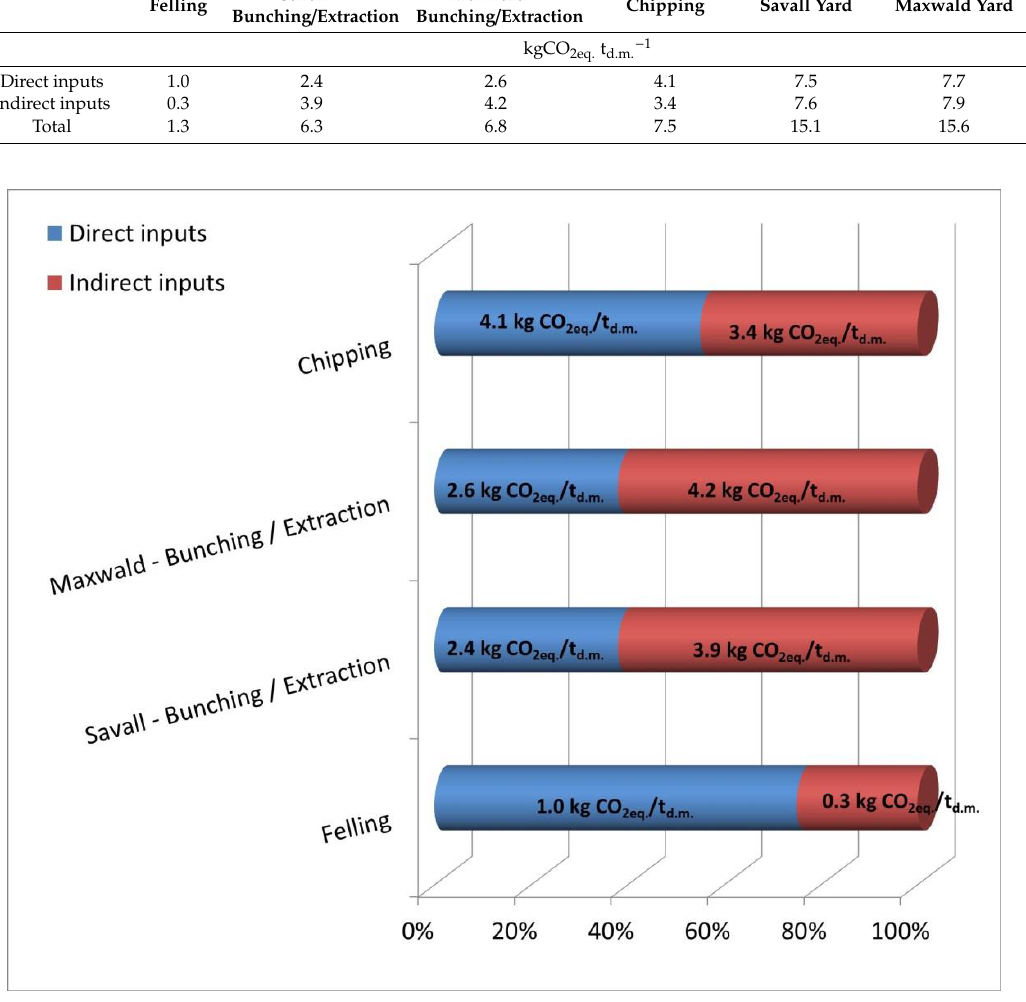
Figure 4. Percentage distribution of total emission in forestry logging yards for single operation, reported in CO 2 equivalent, shared in direct and indirect process.